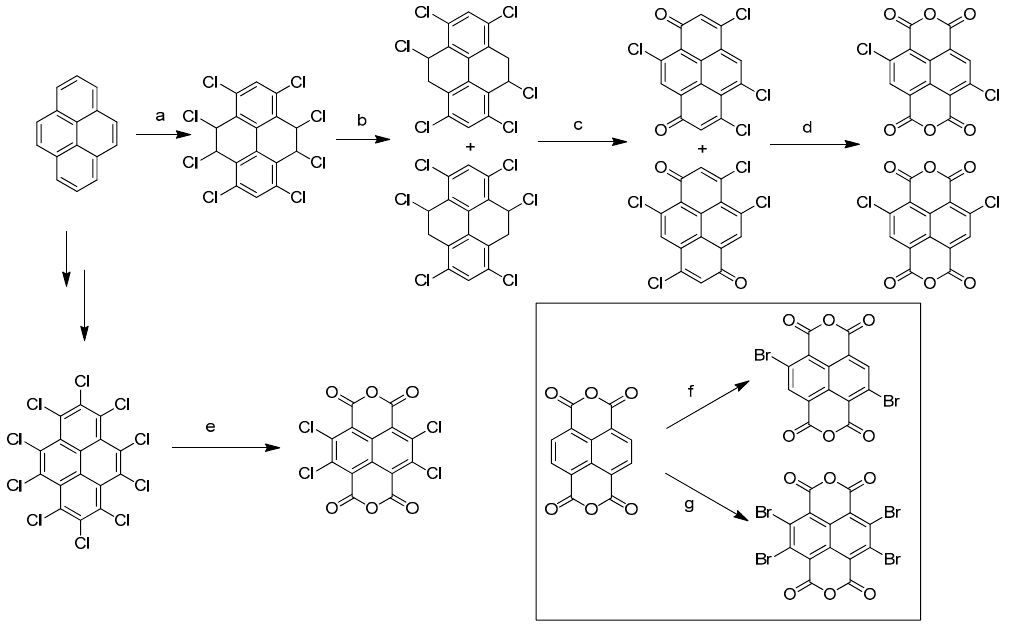
Figure 4. General synthetic route to access chloro and bromo cNDIs. ( a ) Cl 2 ( g ), y = 36–38%; ( b ) KOH/EtOH, y = 96–97%; ( c ) HNO 3 y = 32–45%; ( d ) HNO 3 /H 2 SO 4 , y = 45–50%; ( e ) oleum, 100 ◦ C, y = 25%; ( f ) DBI, oleum, RT, y = 80%; ( g ) excess DBI, oleum, RT, y = 93%.